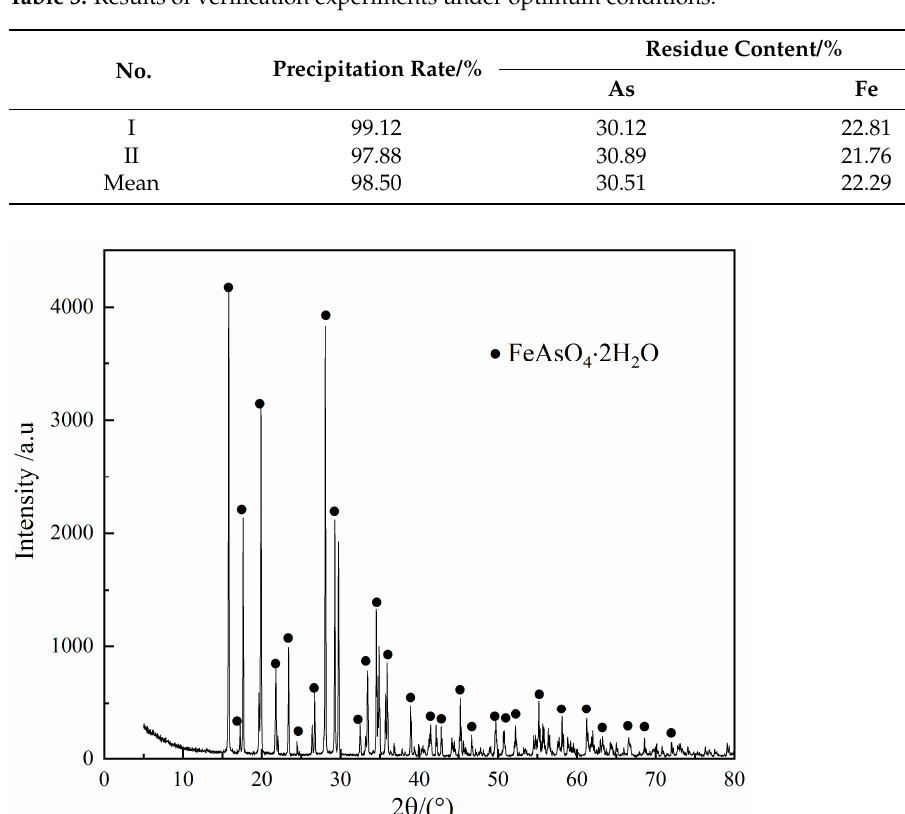
Figure 11. XRD pattern of the precipitation obtained under the optimum conditions.